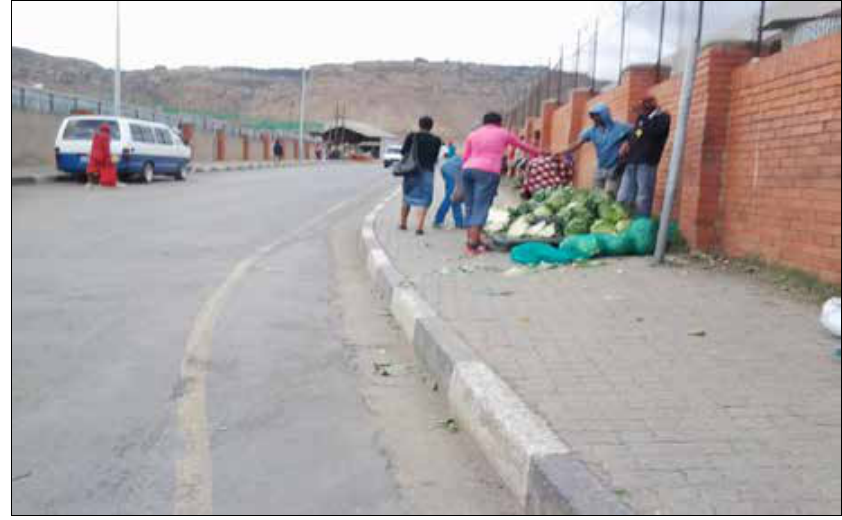
Figure 2: Street-level informal trading focused on workers in AGOA factories